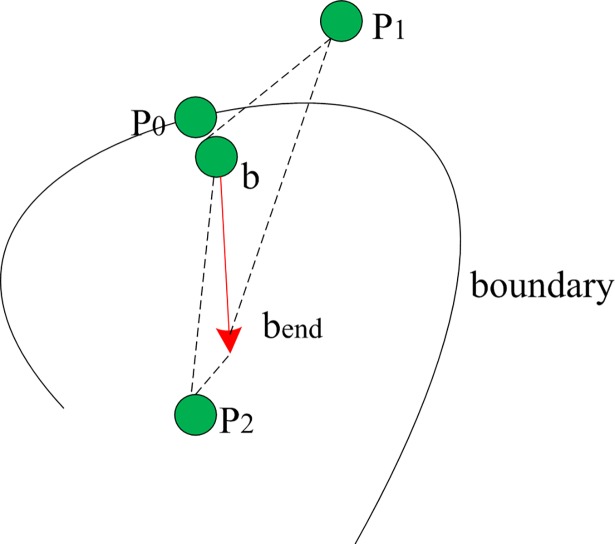
The relationship between a point and a boundary vector.b is a boundary point and its boundary vector is marked with a red arrow. bend represents the end of b’s boundary vector. P0 is a point in the neighbourhood of b and it becomes a new boundary point. P1 is a point outside of the boundary profile since it is closer to b than to bend. P2 is a point inside of the boundary profile since it is closer to bend than b.